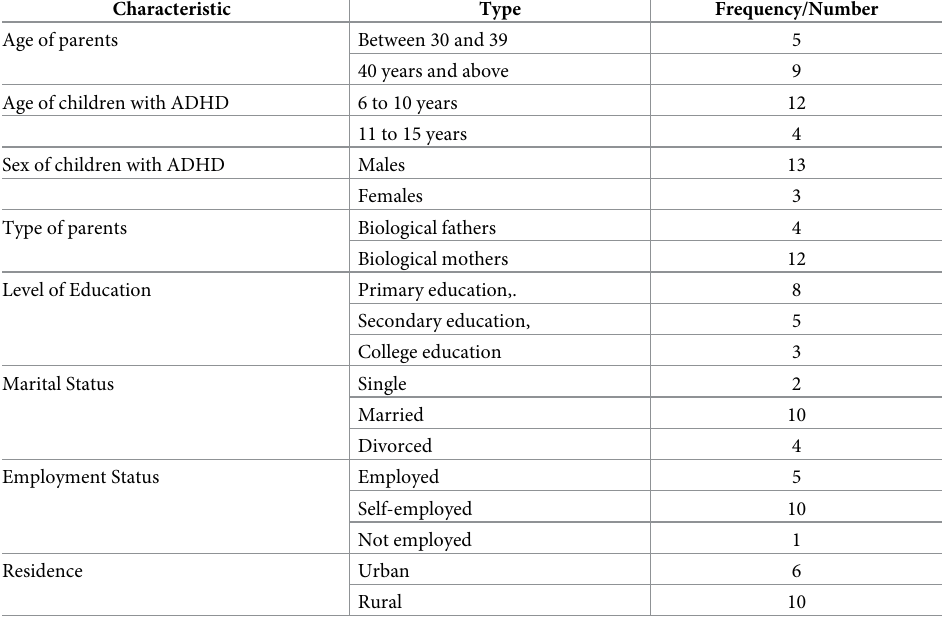
Table 3. Social demographic